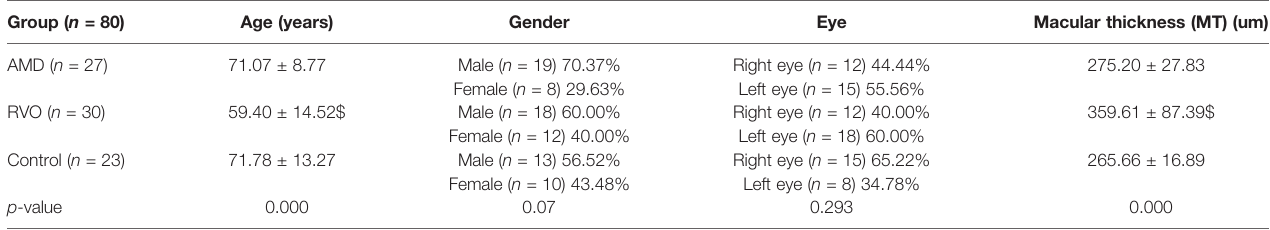
TABLE 1 | Baseline characteristics of the patients in respective